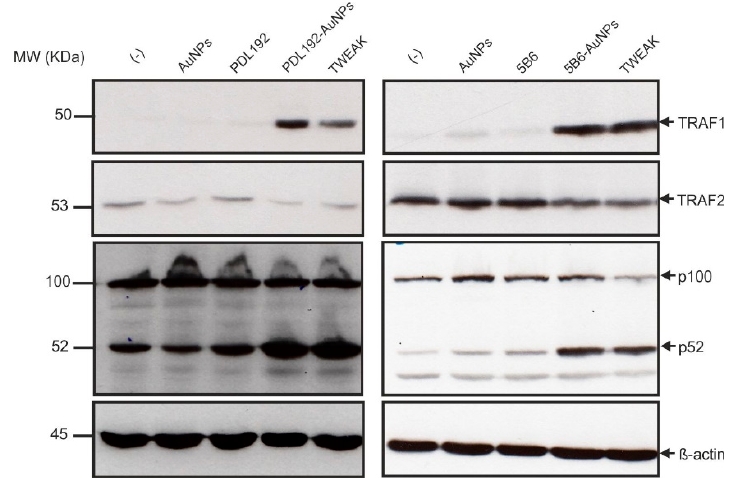
Figure 6. AuNPs-immobilized anti-Fn14 antibodies (PDL192- and 5B6-AuNPs) efficiently trigger p100 processing and induce TRAF1 expression and weak TRAF2 depletion in a similar fashion to sTWEAK. HT1080 cells (1 × 10 6 /well) were seeded in 6-well plates and treated the next day with AuNPs (1 mg/mL), PDL192-AuNPs (1 mg/mL), 5B6-AuNPs (2 mg/mL), PDL192 (400 ng/mL), and 5B6 (400 ng/mL) for 16–18 h. Treatment with Flag-TWEAK (200 ng/mL) served as a positive control. Finally, whole cell lysates were prepared and subjected to western blot analysis to detect TRAF1 induction, TRAF2 degradation, and p100 to p52 processing. Please note, the concentration values of the AuNPs refer to the nanoparticles and not to the amount of conjugated antibody.